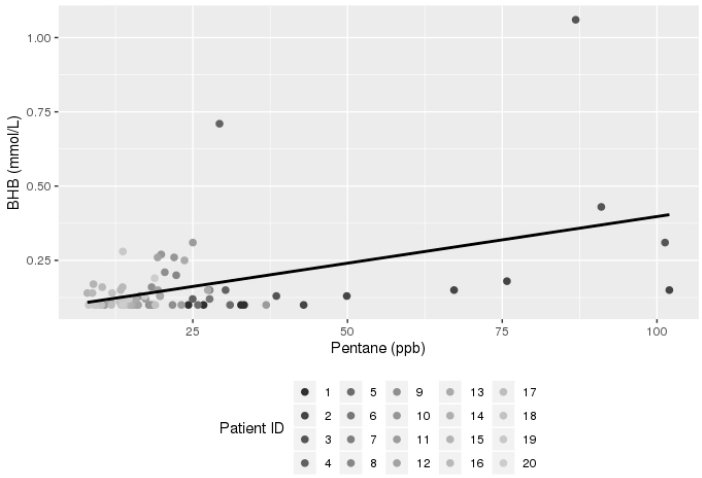
Figure 3. Scatter plot for breath pentane vs. serum ketones (BHB). Dots with the same color shade belong to the same patient.